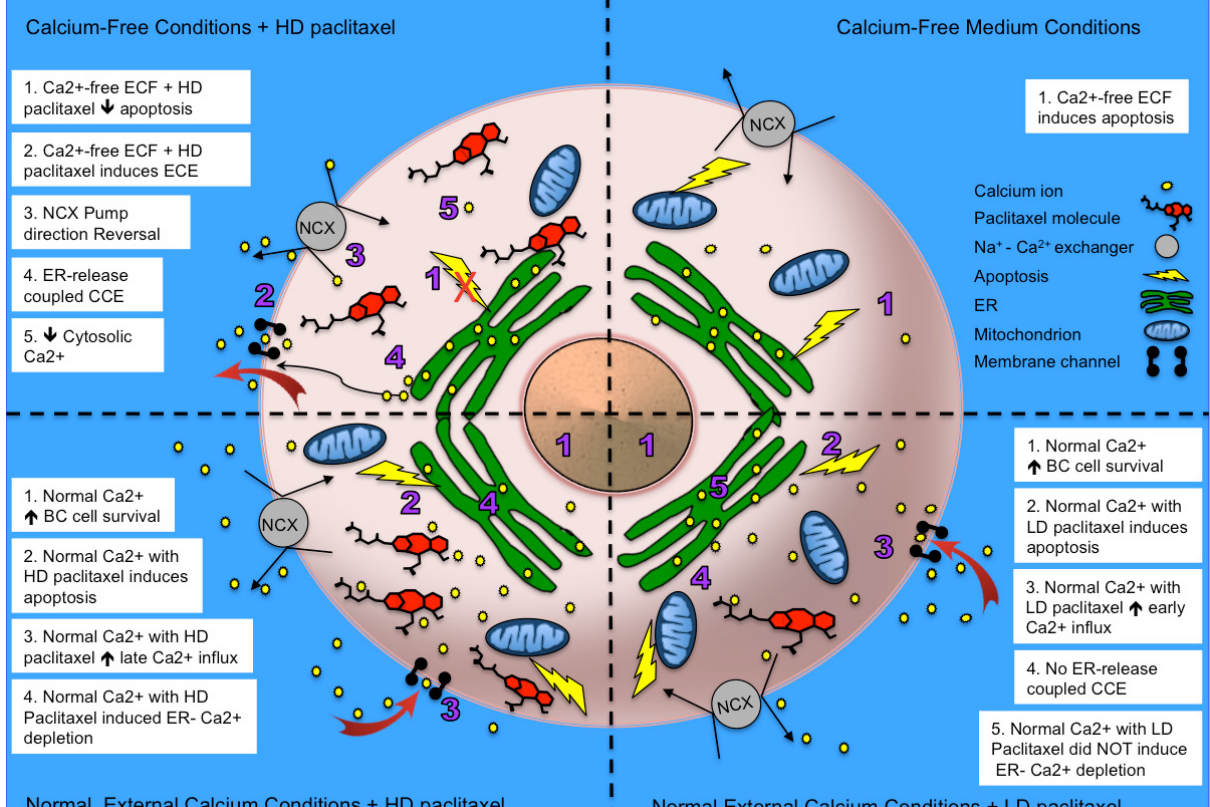
depicted within the cell quadrant. HD = high dose paclitaxel, LD = low dose paclitaxel, NCX = sodium calcium exchange